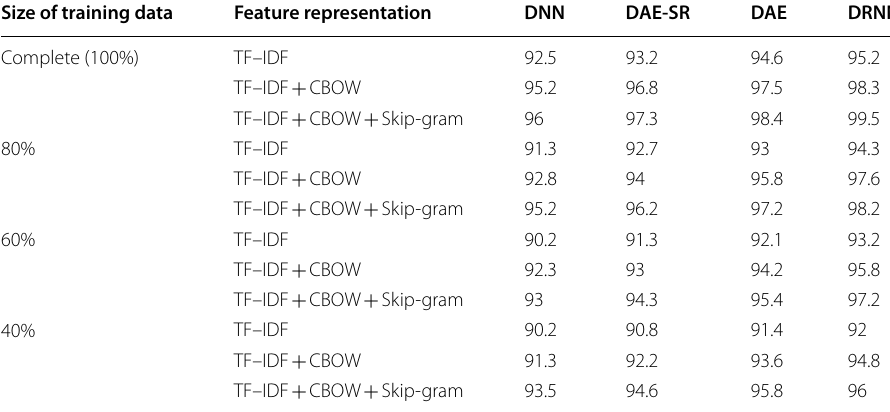
Table 8 Evaluation of accuracy using various feature representations Size of training data